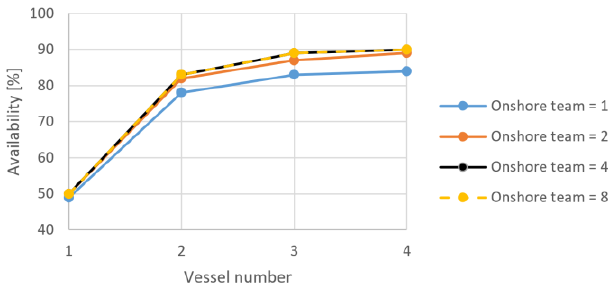
Fig. 20. Farm availability versus vessel number for various numbers of onshore teams, in the case of c/d time=2.5 hr and assembly team=3.